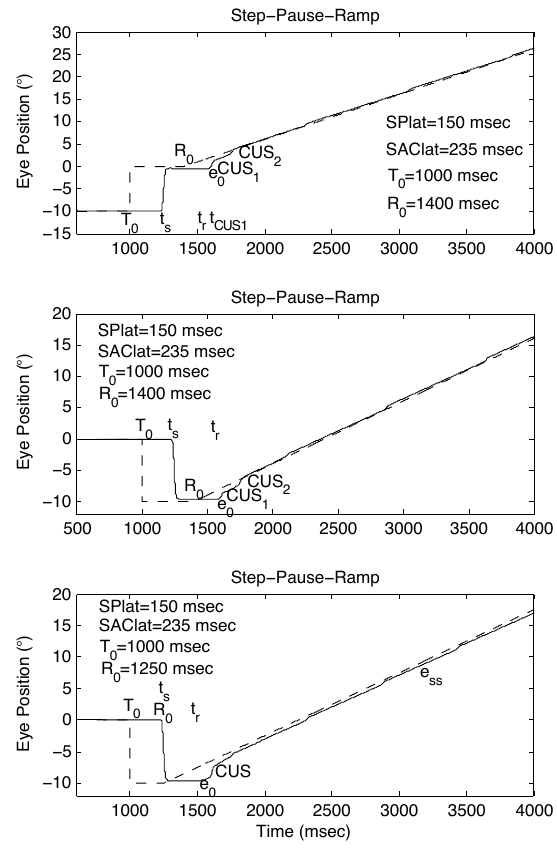
Figure 3. Examples of the different types of responses to SPR stimuli whose ramp initiation occurs near a saccade. The behavioral OMS model simulations demonstrate how small differences in timing can alter the resulting strategy employed by both the saccadic and pursuit systems. (top) Accurate response to SPR stimulus [SPR: -10°, 0°, 10°/sec @ 400 msec]. (middle) Accurate response to SPR stimulus [SPR: 0°, -10°, 10°/sec @ 400 msec]. (bottom) Inaccurate response to SPR stimulus [SPR: 0°, -10°, 10°/sec @ 250